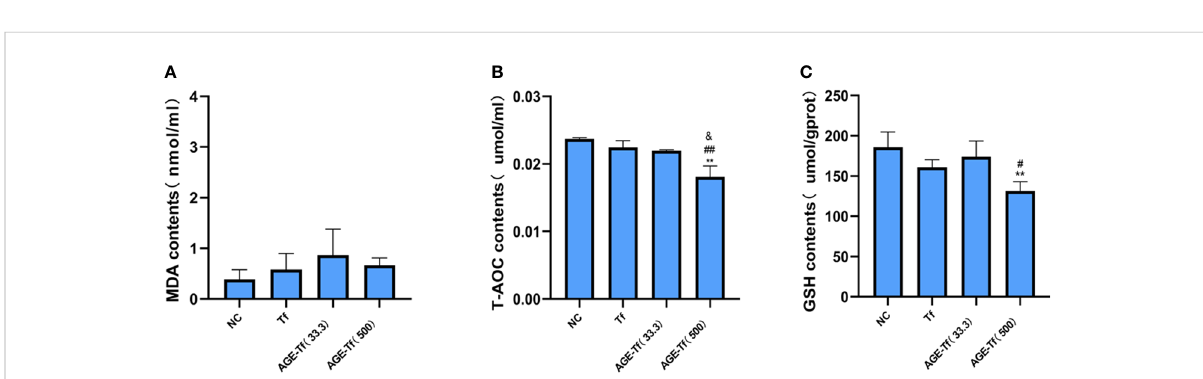
FIGURE 5 Effect of AGE-Tf on oxidative stress of HK-2 cells. (A) Changes in MDA level. (B) Changes in T-AOC level. (C) Changes in GSH level. Compared with the NC group, **p < 0.001. Compared with the Tf group, # p < 0.05, ## p < 0.001. Compared with the AGE-Tf (33.3) group, & p < 0.05. AGE- Tf (33.3): the glucose concentration was 33.3 mM when preparing AGE-Tf; AGE-Tf (500): the glucose concentration was 500 mM when preparing